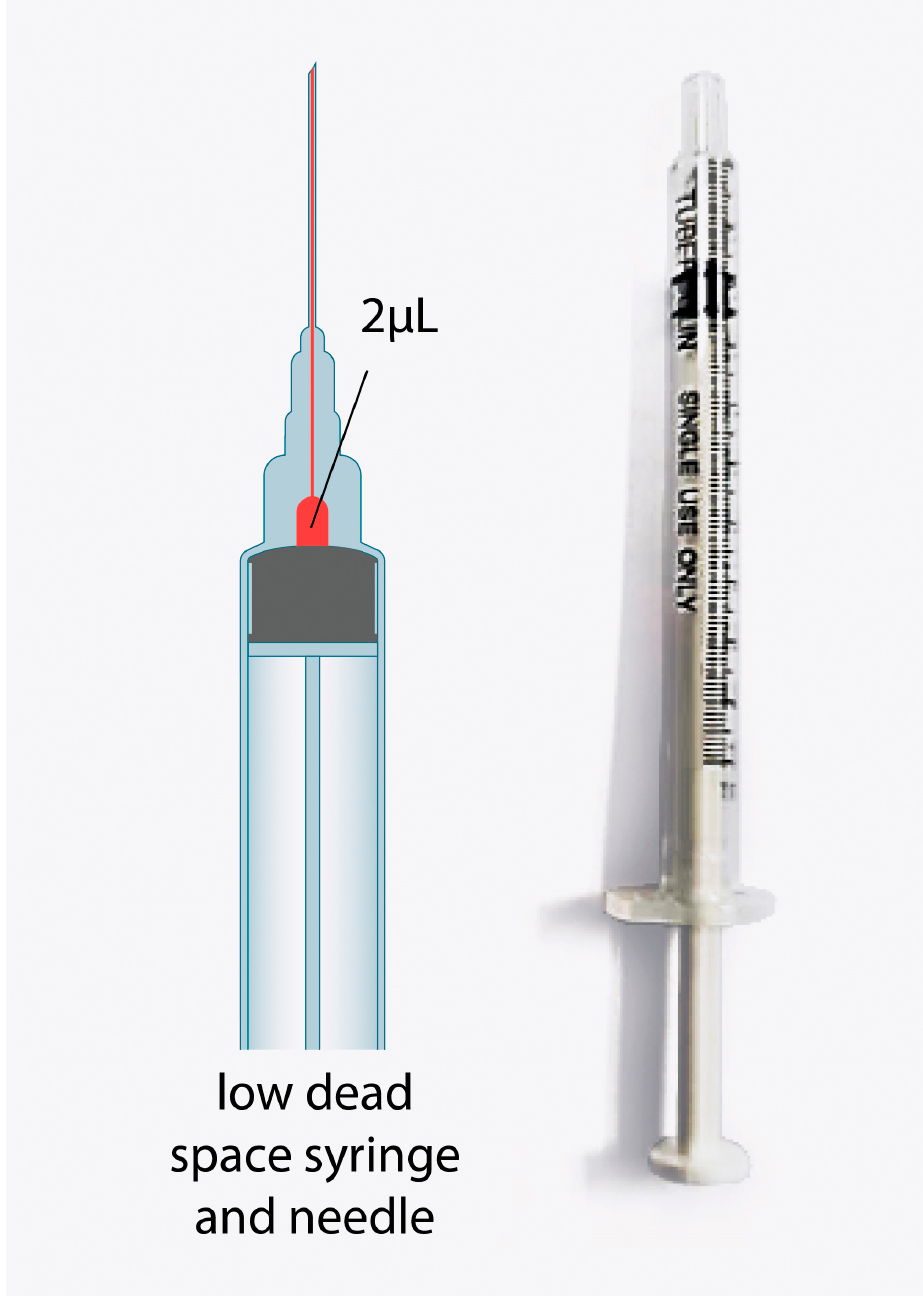
Figure 2. Low dead space syringe and